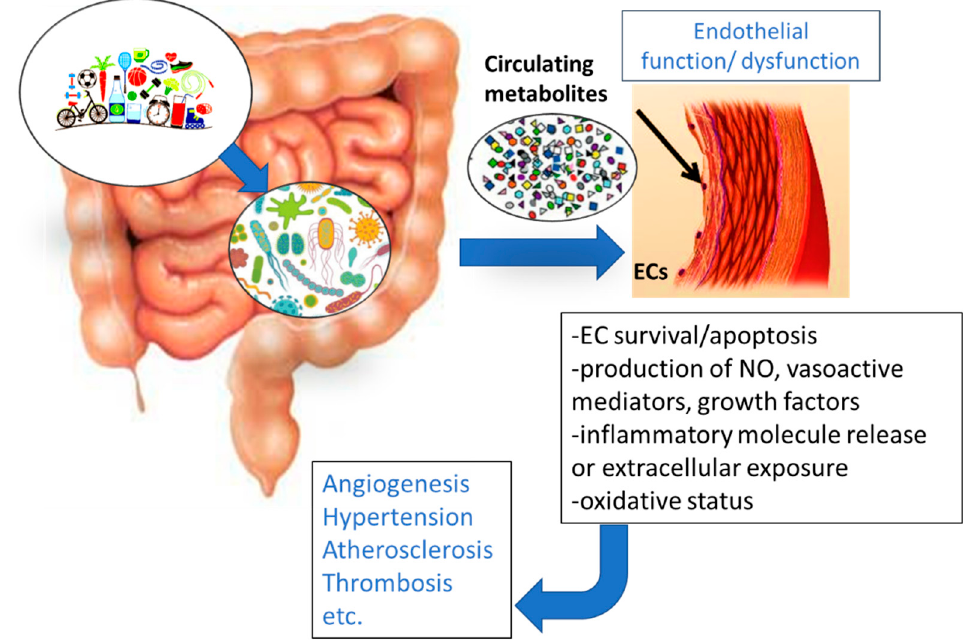
Figure 2. Schematic representation of the activity of circulating metabolites originating from the gut microbiota (GM) on endothelial cell function. Alteration of endothelial viability and metabolism in its turn influences the outcome of hypertension, atherosclerosis, and other CVDs, and the type and extent of the angiogenic response.